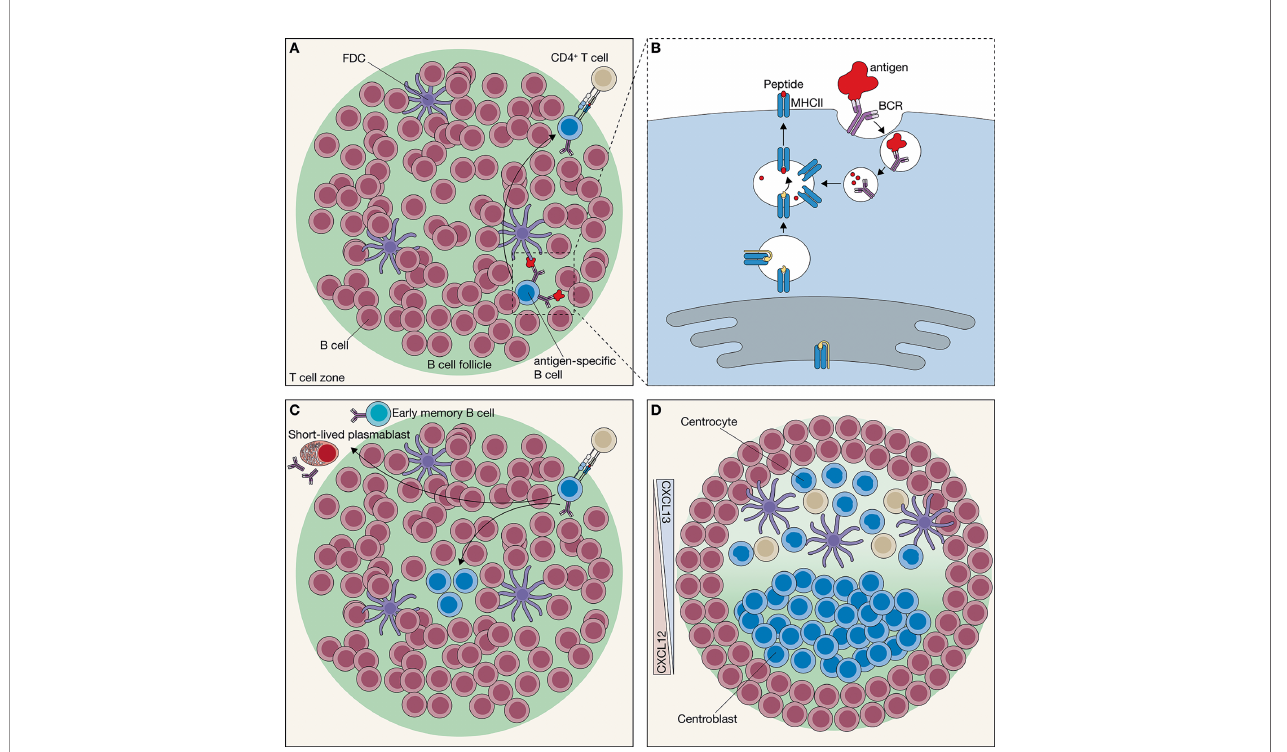
FIGURE 1 | Initiation of the germinal center (GC) network. (A) In the secondary lymphoid organs, B cells are located in the B cell follicle. Follicular B cells engage with an Antigen (Ag) via their B cell receptor (BCR). Most Ag in the follicle is presented by follicular dendritic cells (FDCs), which retain the Ag for extended periods. Ag engagement partly activates the follicular B cells; however, to become fully activated, it requires interaction with a CD4 + T cells. Ag-engaged follicular B cells localize to the border of the follicle to encounter CD4 + T cells with the same Ag speci fi city. (B) To interact with the CD4 + T cells, the B cell needs to present Ag-derived peptide fragments through the major histocompatibility complex class II (MHCII). Thereto, Ag engagement results in BCR-mediated endocytosis, followed by Ag degradation and presentation of resulting peptide fragments through MHCII. (C) At the border of the follicle, CD4 + T cells screen many Ag-speci fi c B cells to fi nd the B cell with the same Ag speci fi city. At the time the CD4 + T cell encounters a follicular B cell with a corresponding Ag speci fi city, it provides the B cell with help that in turn results in the differentiation towards either short-lived plasmablasts, early memory B cells or GC precursor B cells. GC precursor B cells migrate towards the center of the follicle